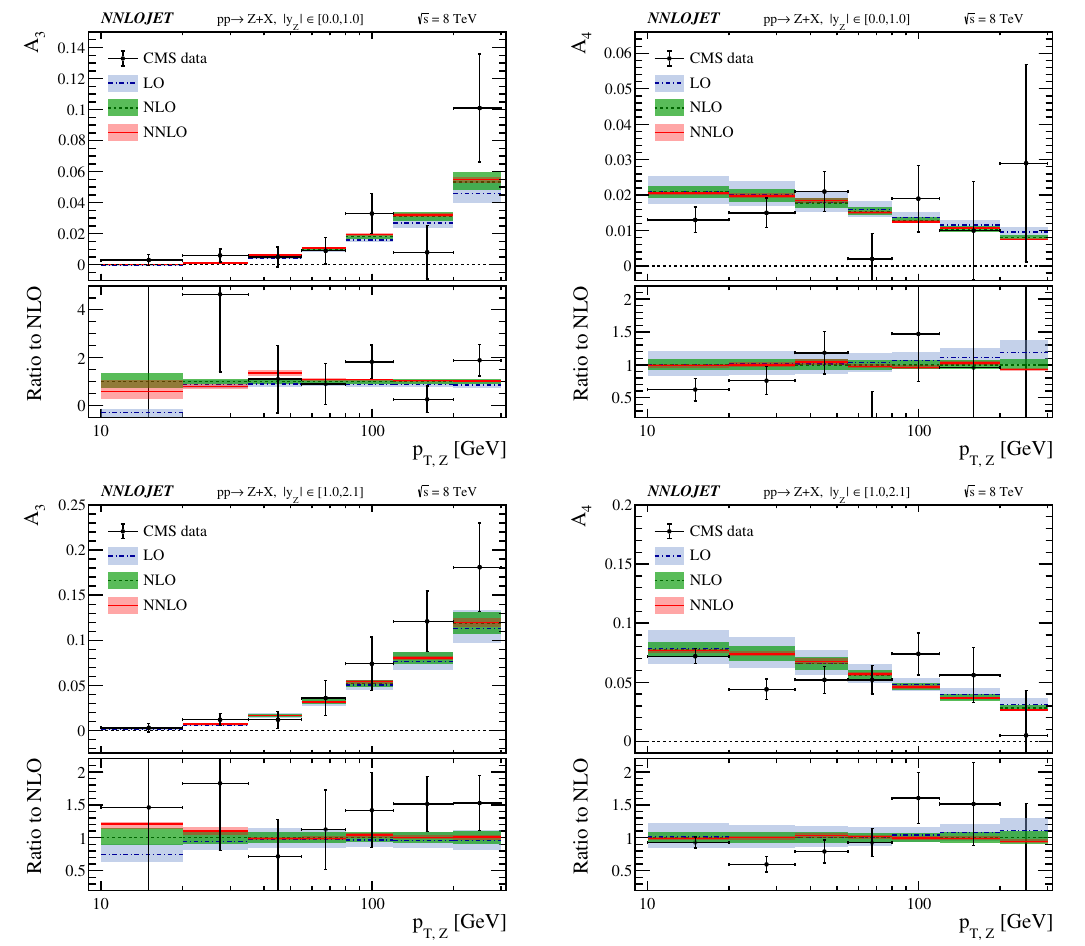
Figure 8 . The p T ; Z distribution for the angular coe(cid:14)cients A 3 (left) and A 4 (right) in pp p collisions at s = 8 TeV, where kinematic cuts of j y Z j 2 [0 : 0 ; 1 : 0] (left) and j y Z j 2 [1 : 0 ; 2 : 1] have been required for the shown distributions. The CMS data (black points) are compared to the LO (blue (cid:12)ll), NLO (green (cid:12)ll), and NNLO (red (cid:12)ll) theoretical predictions. In the lower panel, each distribution is shown normalised with respect to the central NLO